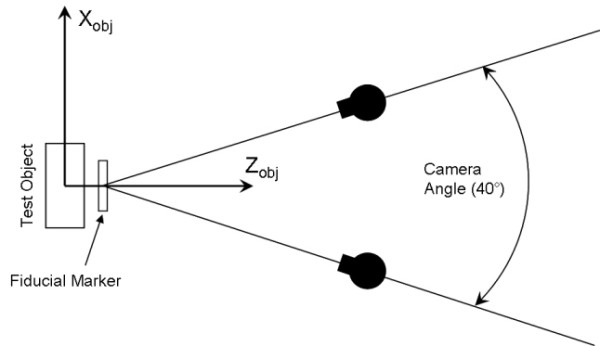
Top view of the camera setup. The Yobj axis is directed towards the reader.